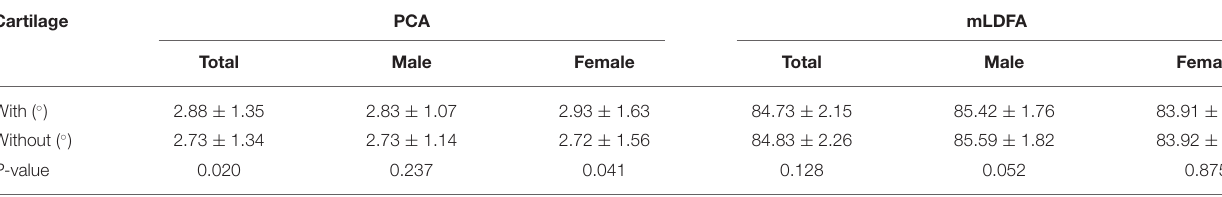
TABLE 1 | The posterior condylar angle (PCA) and the mechanical lateral distal femoral angle (mLDFA). Cartilage